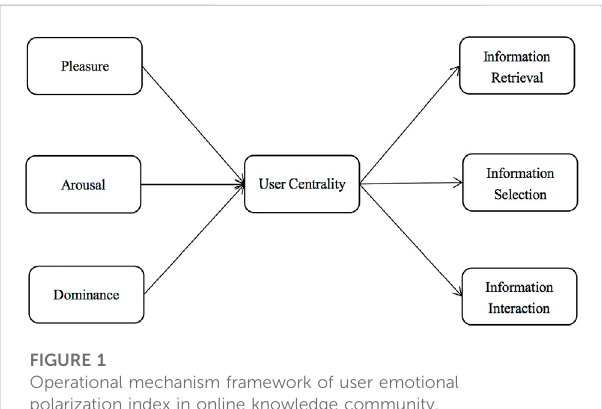
FIGURE 1 Operational mechanism framework of user emotional polarization index in online knowledge